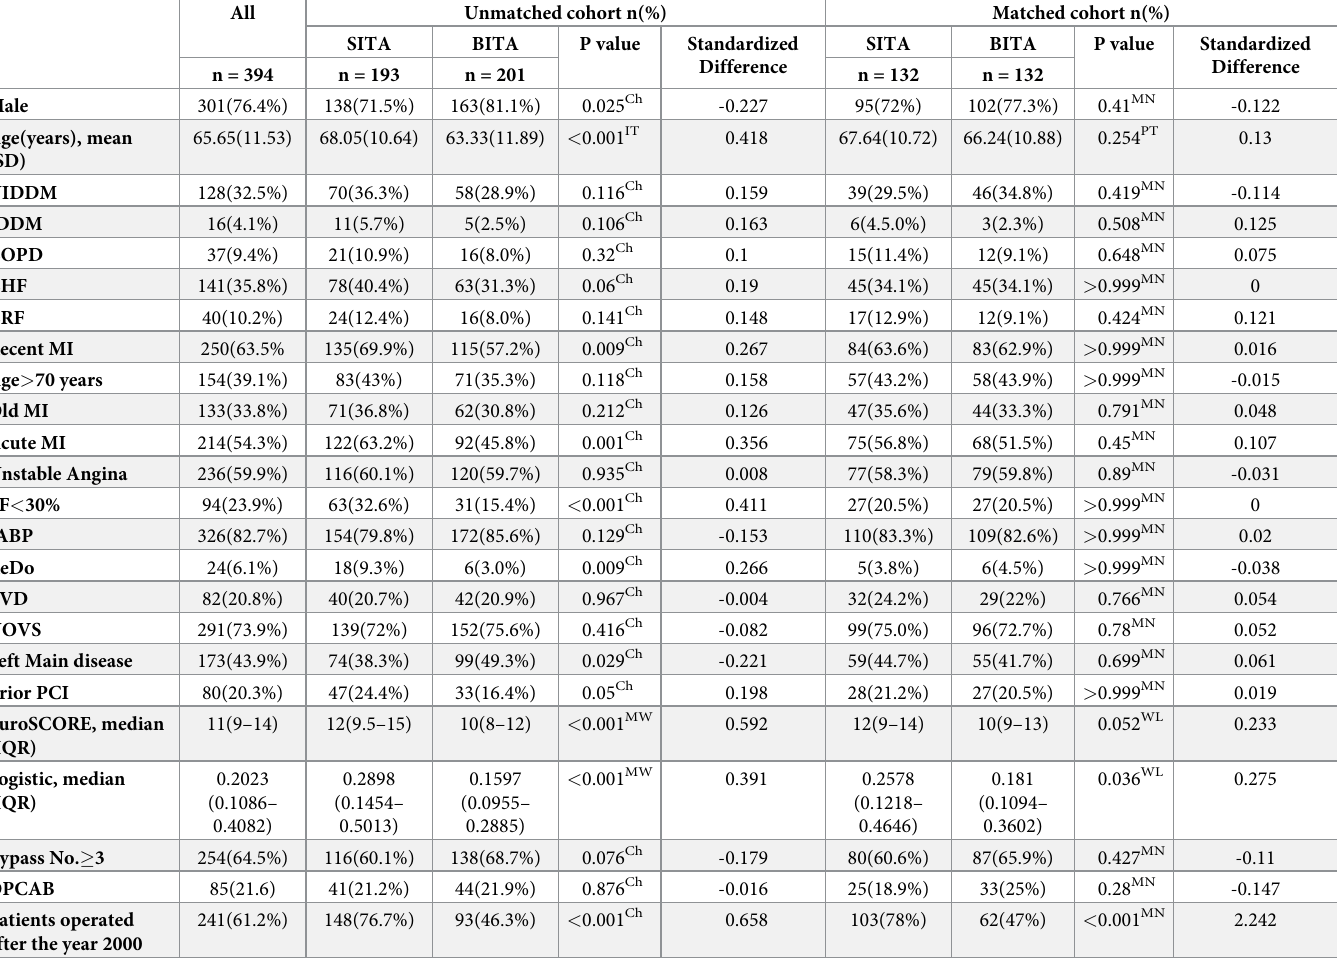
Table 1. Preoperative and intraoperative characteristics of critical patients who underwent SITA and BITA grafting revascularizations—Unmatched and matched